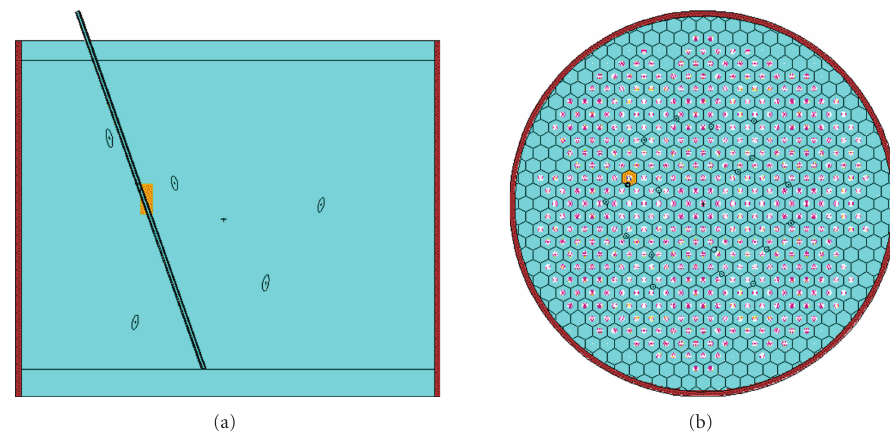
Figure 10: Equivalent NESTLE composition in MCNP5 core model, axial view.